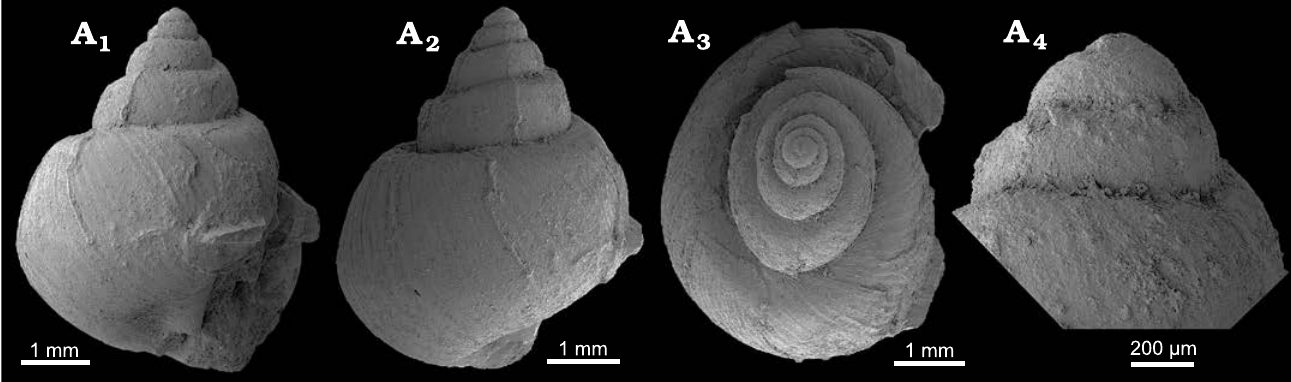
Fig. 6. Turbinid? gastropod “ Turbo ” sp., PZO 12740, from Misurina Landslide, northern Italy, Cassian Formation, Carnian, Upper Triassic. In apertural